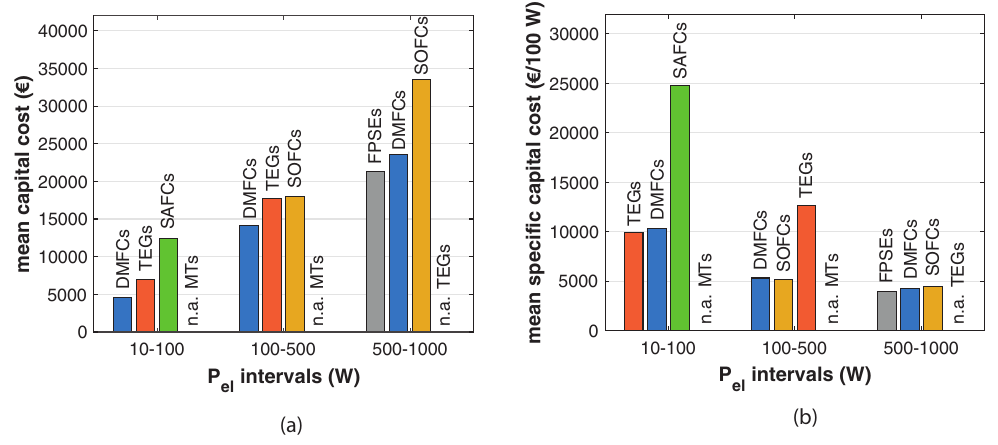
Figure 16. Comparison of the economic features: ( a ) mean and ( b ) specific capital cost. Table 3 collects the main economic data of the technologies for remote power genera- tion in the gas